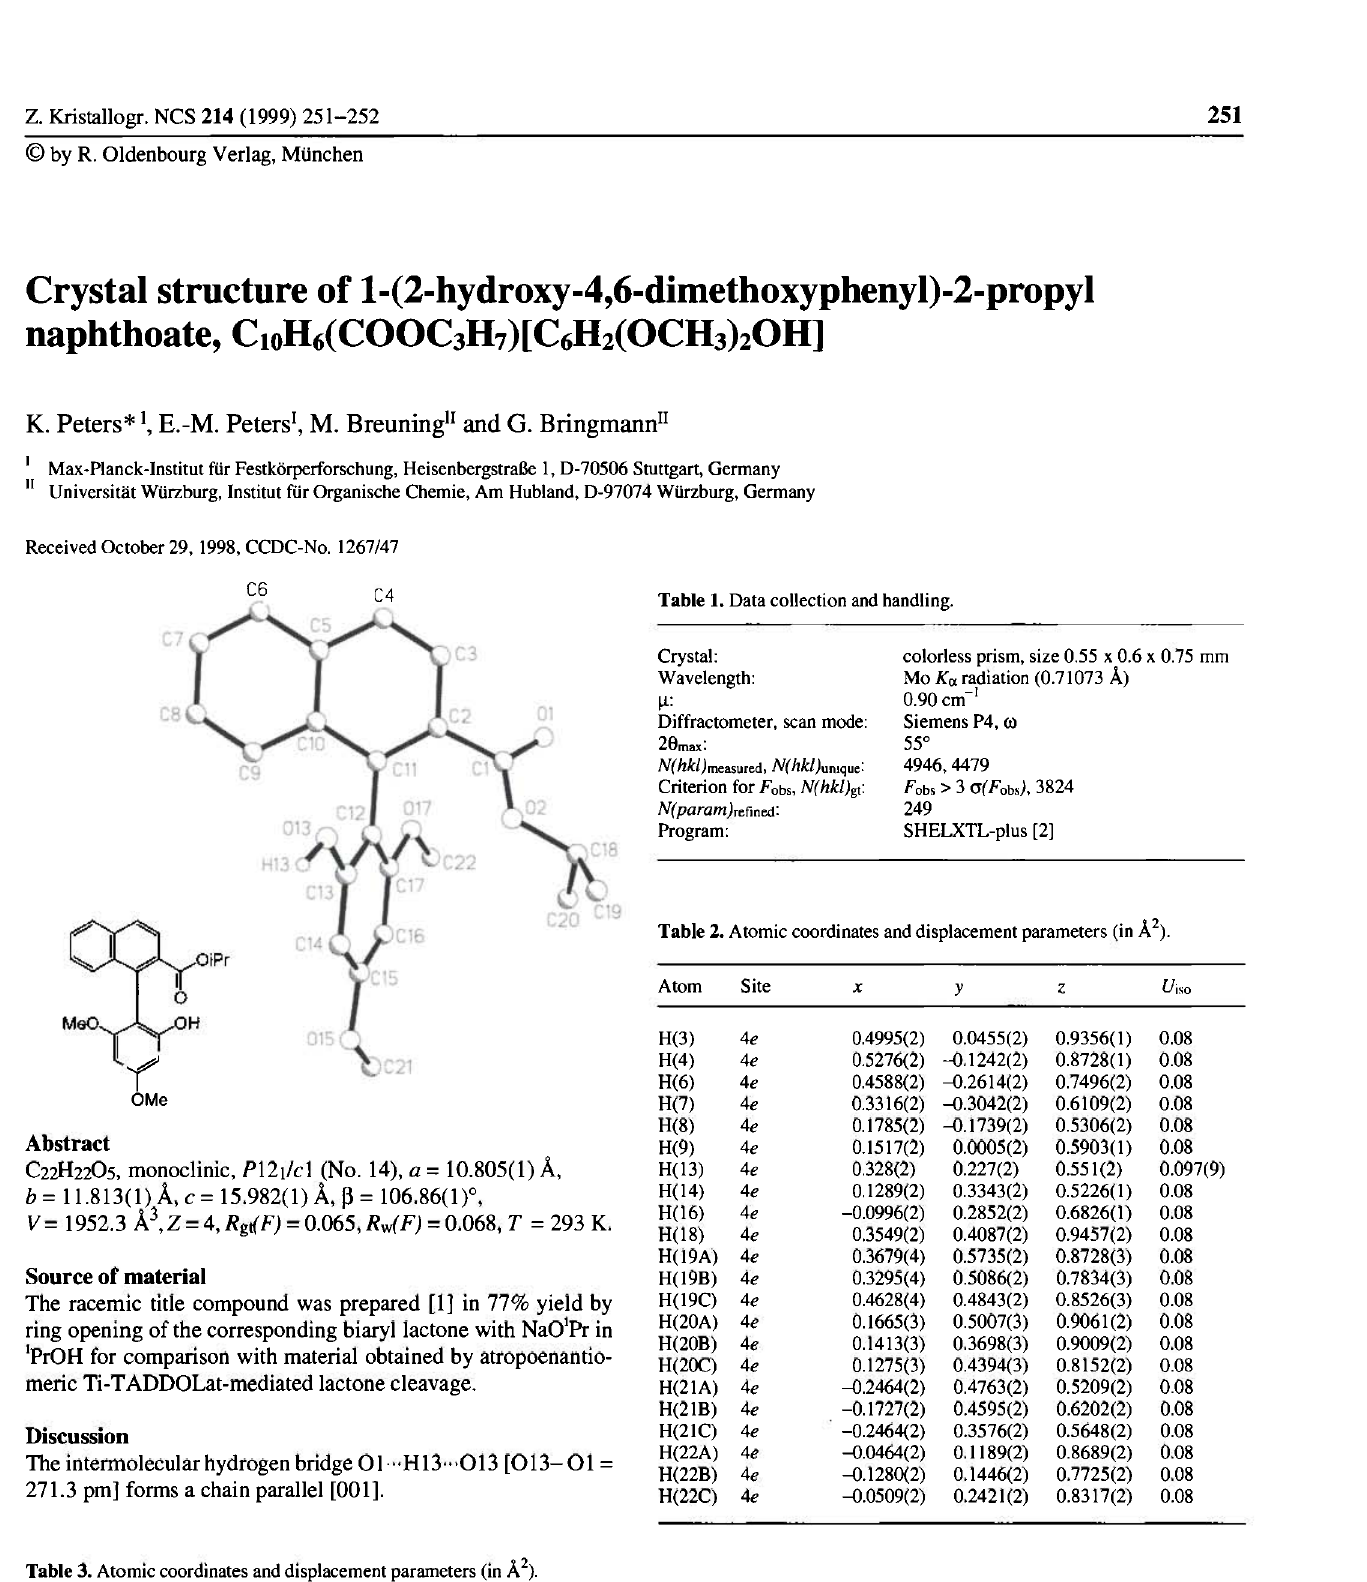
Table 3. Atomic coordinates and displacement parameters (in Ä 2